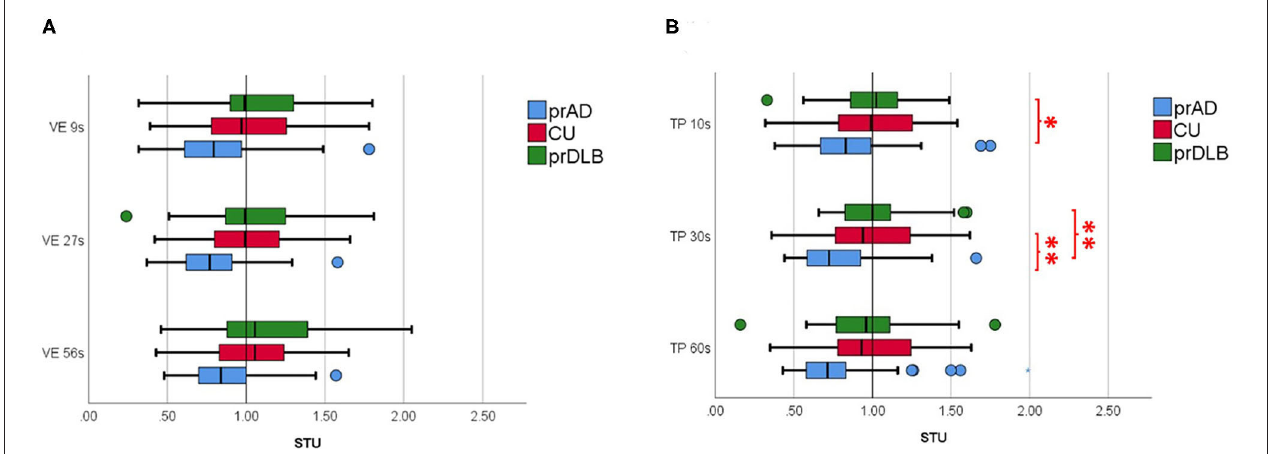
FIGURE 2 | The subjective temporal unit (STU) of the participants in (A) verbal time estimation (VE) and in (B) time interval production (TP) in different time intervals. prAD, prodromal AD dementia; CU, cognitively unimpaired; prDLB, prodromal dementia with Lewy bodies (* p < 0.05, ** p <